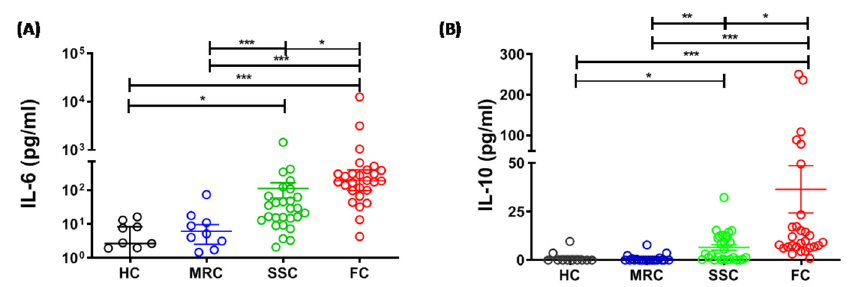
Figure 1. ( A ). IL-6 levels in healthy controls (HC), mild recovered cases (MRC), survived severe cases (SSC), and fatal cases (FC). ( B ). IL-10 levels in HC, MRC, SSC, and FC. Circles represent the cytokine level of individual subjects and lines indicate median and interquartile range. * p < 0.05; ** p < 0.01; *** p <0.001.